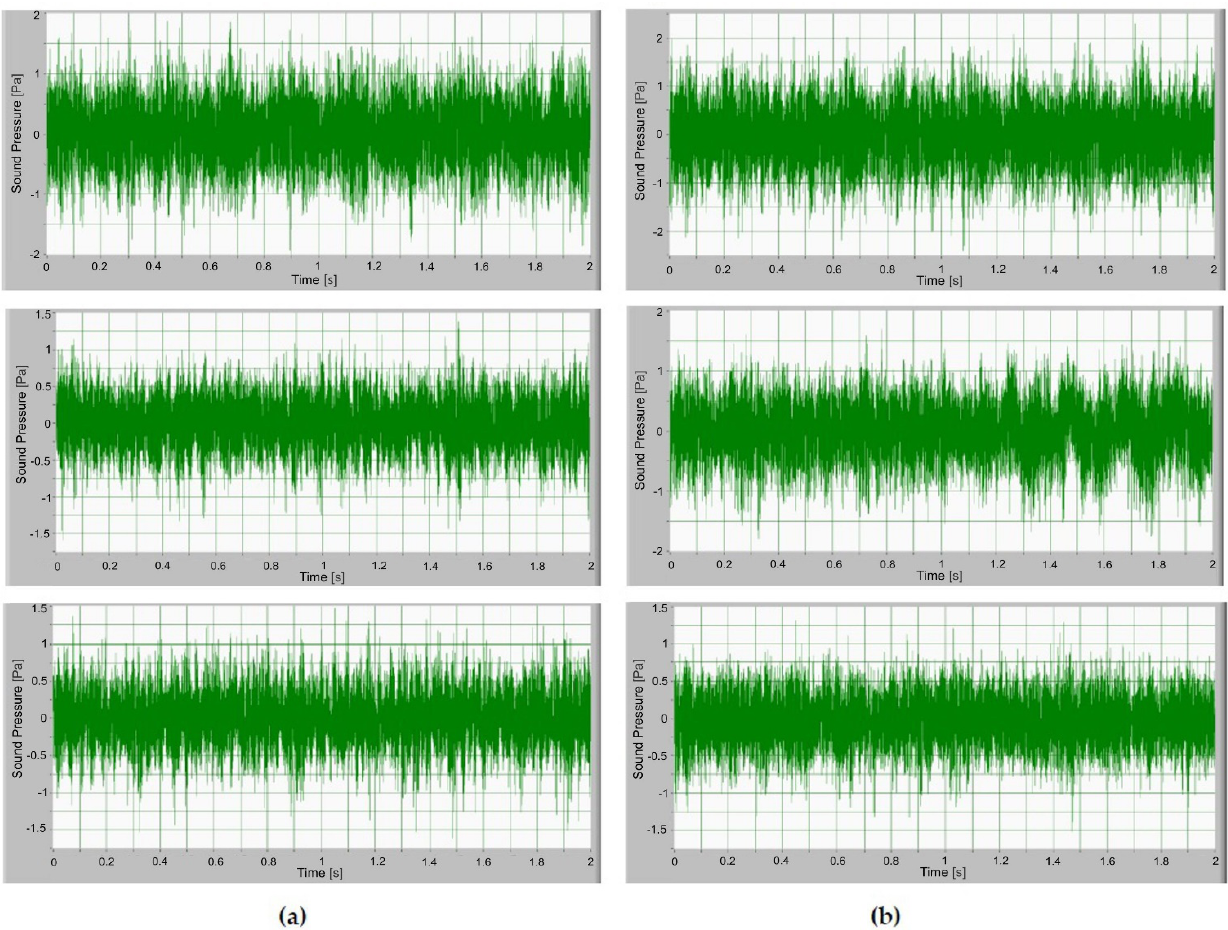
Figure 6. Time signal of sound pressure for gears loaded with torque 1.5 Nm, 1.3 Nm and 1.1 Nm: ( a ) S − polymer gears, ( b ) involute polymer gears (E − gears).